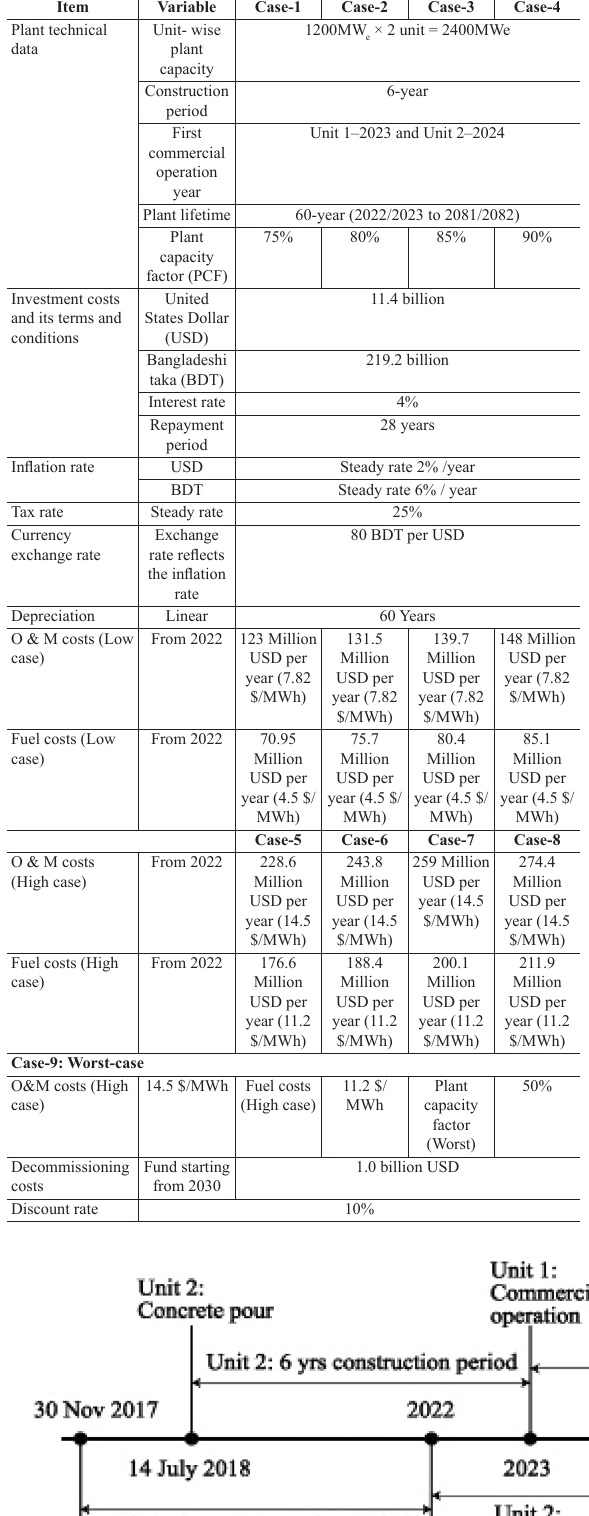
Table 1. Some key plant technical, economic, and financial data at nine different postulated cases considering low and high val - ues of O&M costs and fuel costs (WNA 2020, Paks II 2015).